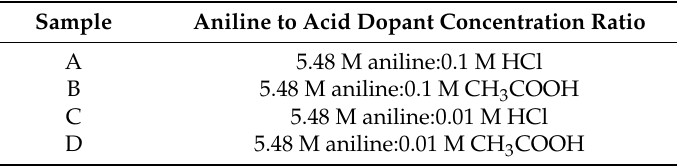
Table 1. Polyaniline samples with different aniline and acid dopant concentration